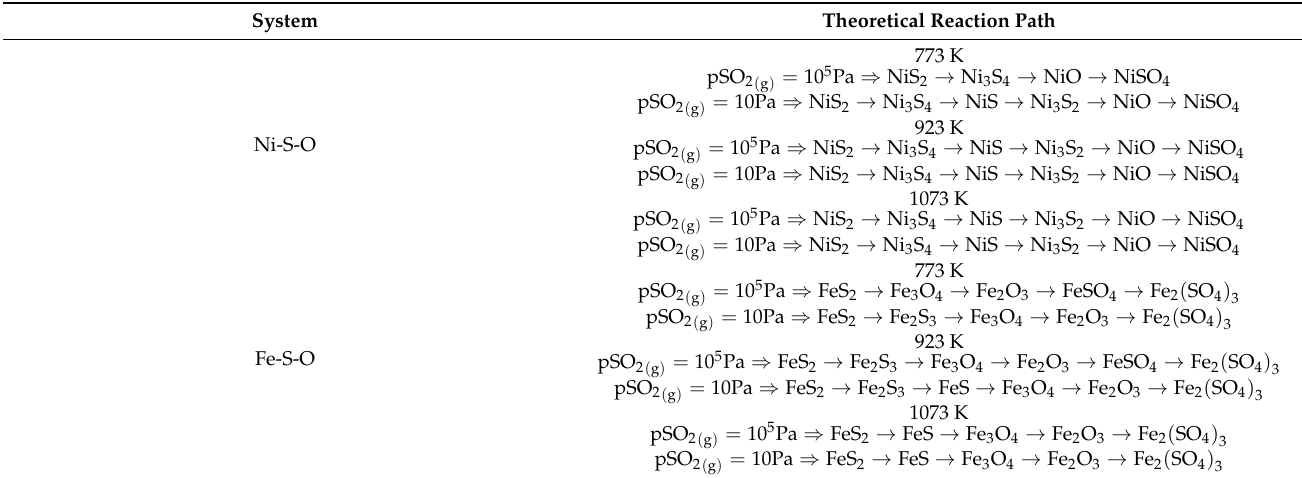
Table 3. Theoretically proposed reaction paths for oxidation process in the Ni-S-O and Fe-S-O systems. System